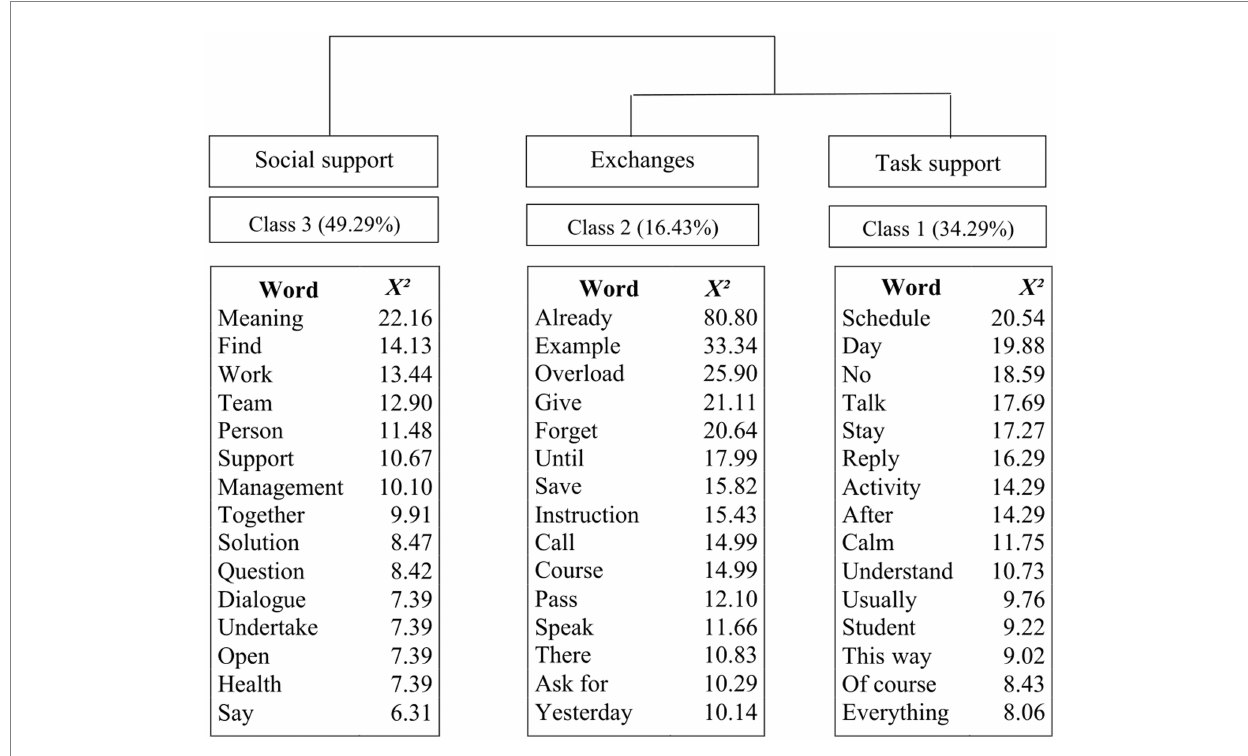
FIGURE 1 Descending hierarchical classification (DHC)